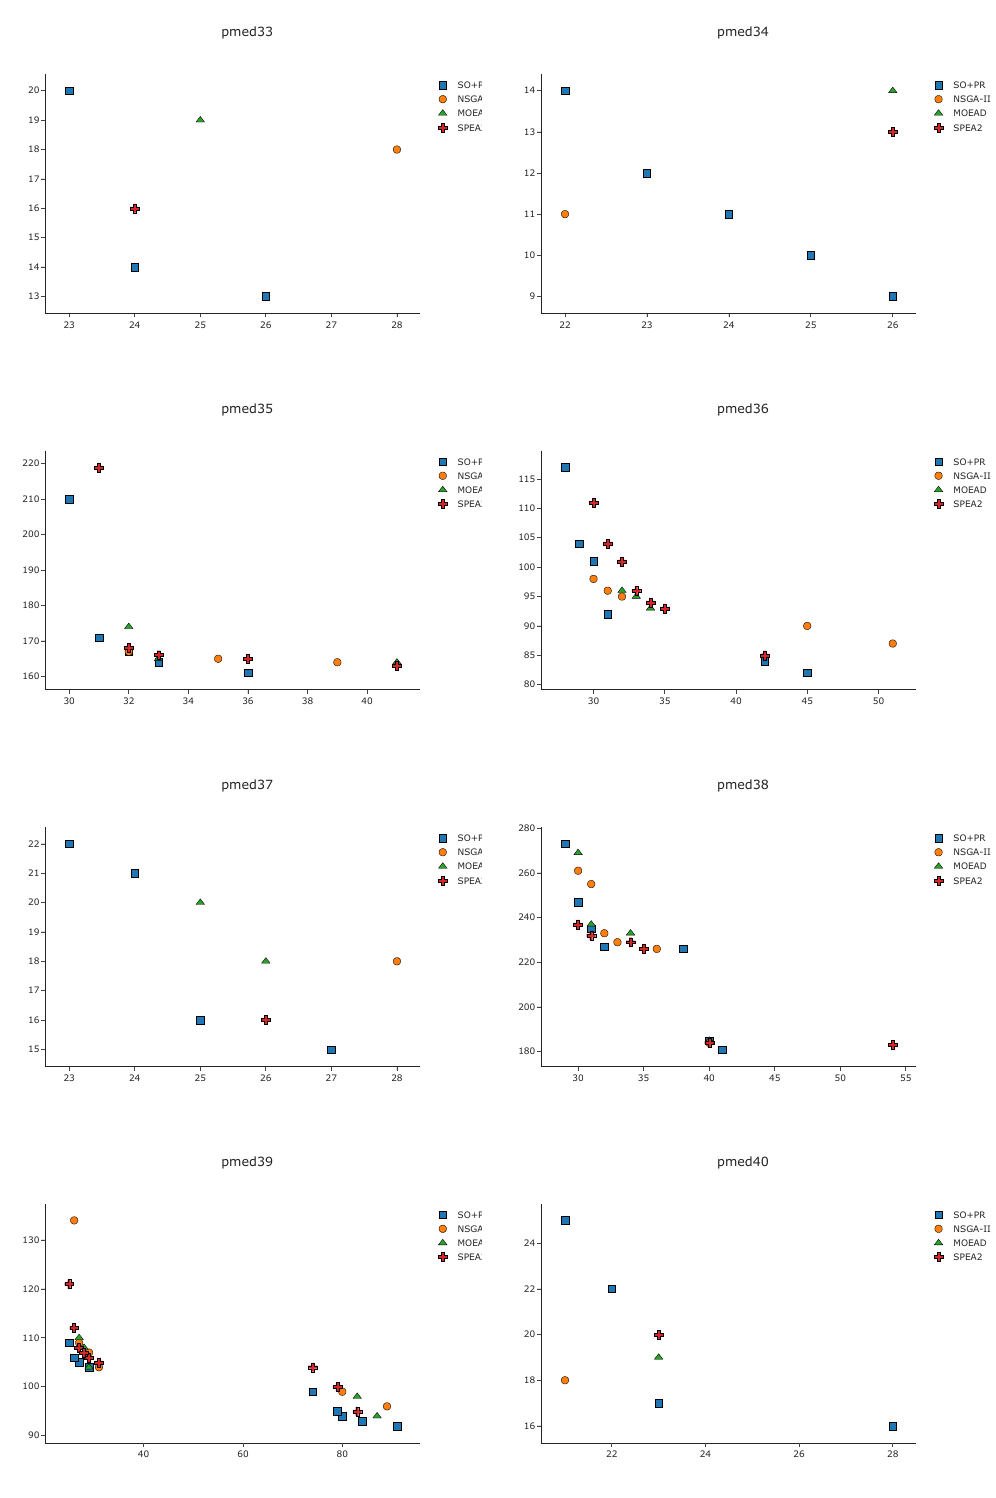
Figure A4. Efficient sets of solutions for SO+PR , MOEAD , NSGA-II , and SPEA2 for instances pmed31 to